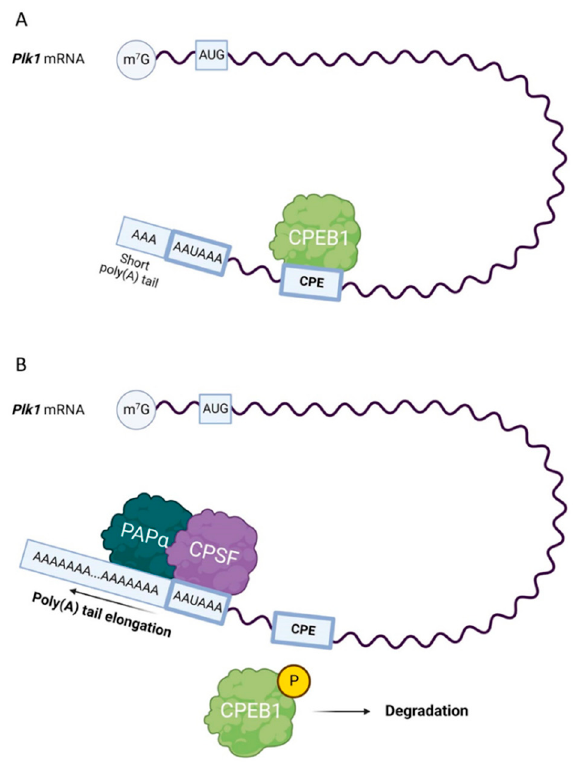
Figure 1. Scheme of polo-like kinase 1 ( Plk1 ) mRNA translation. ( A ) Cytoplasmic polyadenylation element-binding protein 1 (CPEB1) represses the translation of CPE-containing mRNAs with short poly(A) tails, including Plk1 mRNA. Phosphorylated CPEB1 promotes the binding of the cleavage and polyadenylation specificity factor (CPSF) complex to the hexanucleotide sequence (AAUAAA). ( B ) In mouse oocytes, CPSF recruits poly(A) polymerase α (PAP α ), which promotes poly- adenylation.